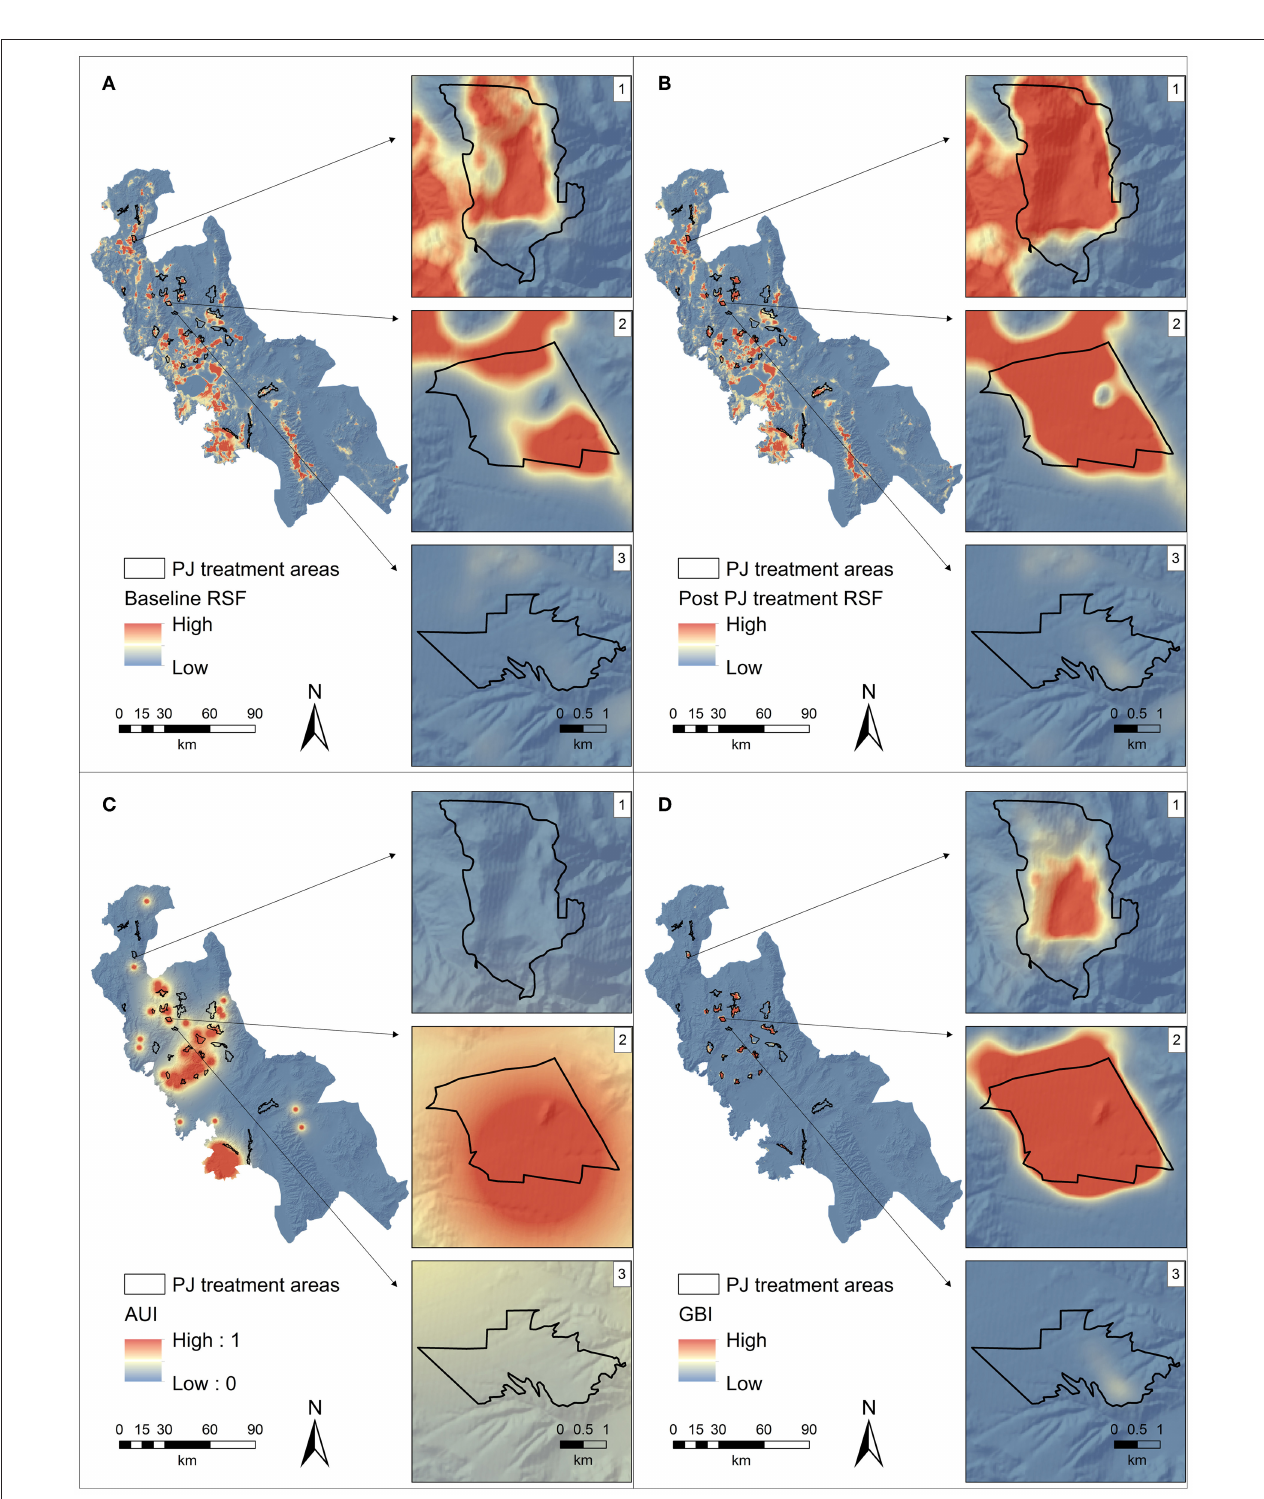
FIGURE 7 | Example spatially explicit illustration of effects of simulated conifer removal and subsequent change in ecological benefit to sage-grouse to prioritize treatments. Here, resource selection function (RSF) values between baseline (A) and post cover-class 1 pinyon-juniper removal (B) surfaces are subtracted, and then multiplied by an intersecting abundance and space use index (AUI) (C) to calculate a sage-grouse benefit index (GBI) (D) . Side panels illustrate how high GBI rankings can be driven by high RSF change and low AUI (1), high RSF change and high AUI (2), and low RSF change and moderate AUI (3). Used with permission from Ricca et al.